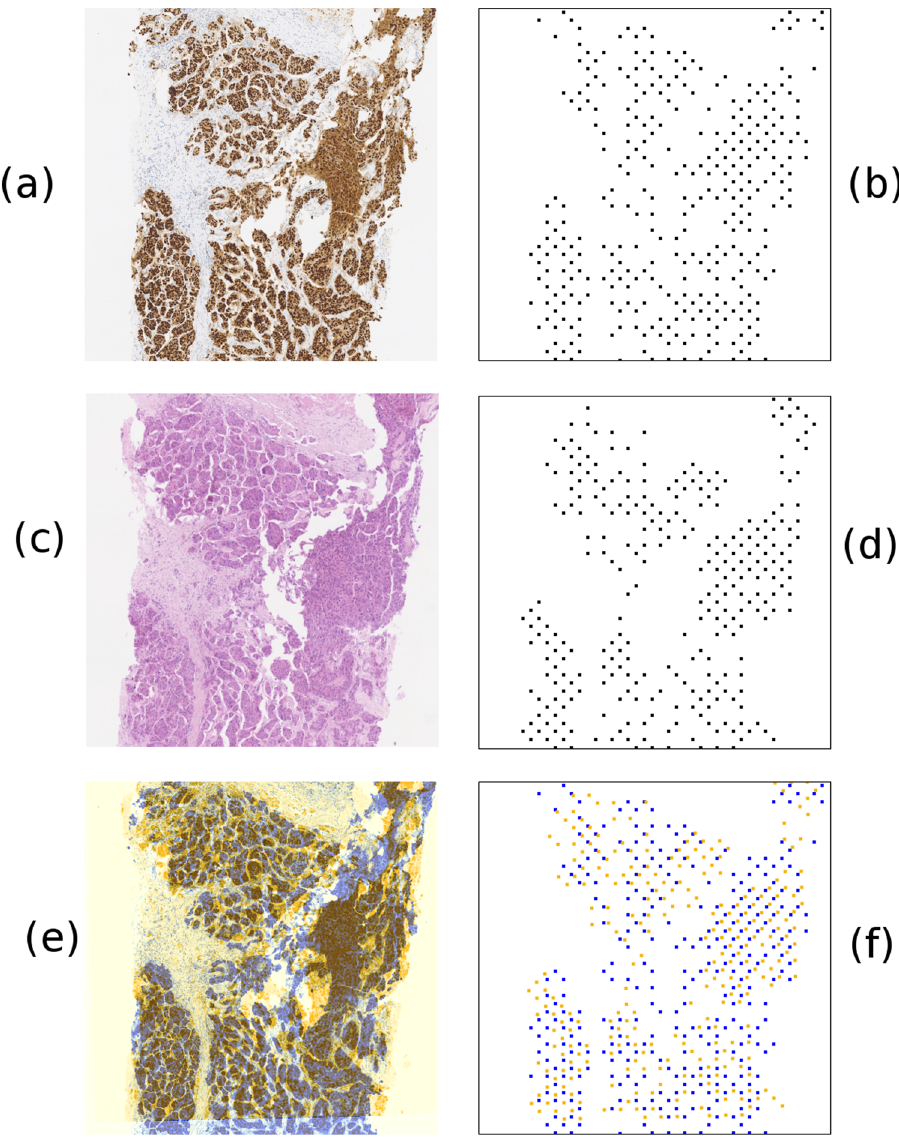
Figure 8. A demonstration of the nuclei cluster detection on two breast tissue slides. Despite many differences in the images, the extracted features are arranged very similarly and register the image well. A visual field from an ER stained slide is shown in Fig. 8a, with its nuclei cluster detection results shown in Fig. 8b. A visual field from an H&E stained slide is shown in Fig. 8c, with its nuclei cluster detection results shown in Fig. 8d. The registered visual fields are shown as a false colour image in Fig. 8e, with the ER image in blue and the H&E image in orange. The positions of the detected nuclei clusters following registration are shown in Fig. 8f, ER detections are shown in blue and H&E detections are shown in